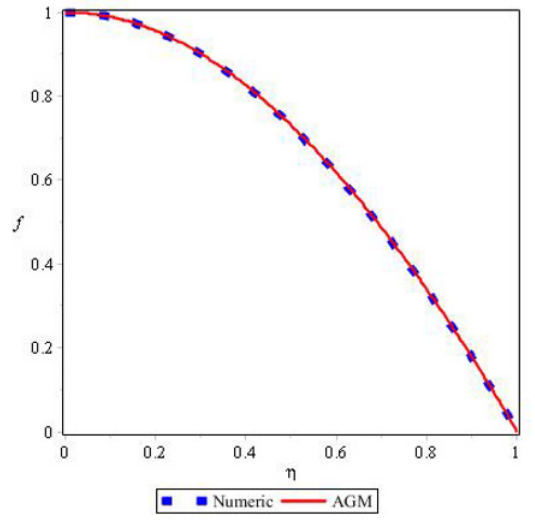
Figure 9. Comparison between the obtained solutions for f AGM and Numerical